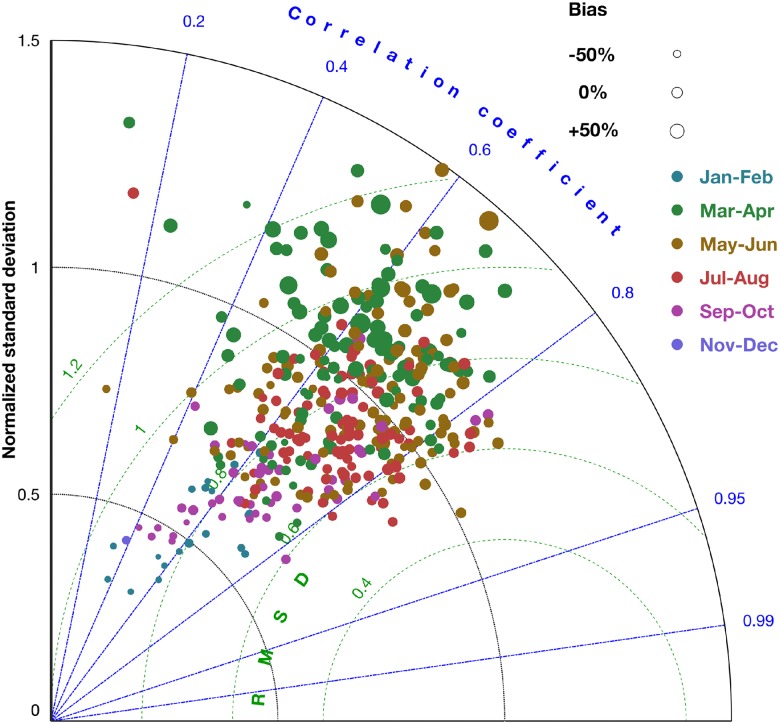
Temporal sequence of surface chlorophyll-a in 2004 for the three scenarios compared to observations.Maps derived from remote sensing (ESACCI, top row), and from three different simulations, the simulation lacking virus dynamics (2nd row), the reference run (3rd row), and the run with spatially uniform carnivory (4th row).